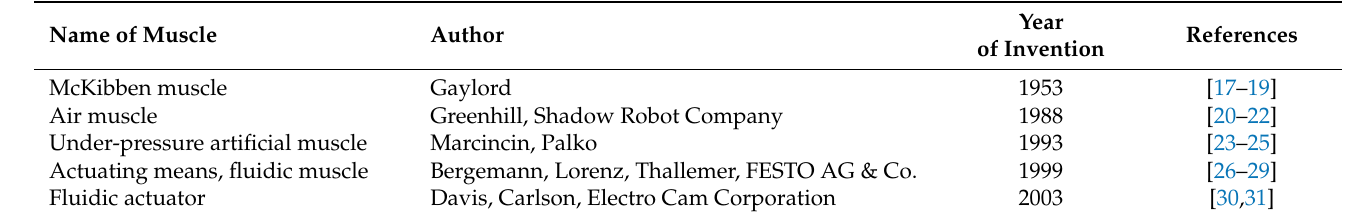
Table 1. Chronological overview of some braided pneumatic artificial muscles